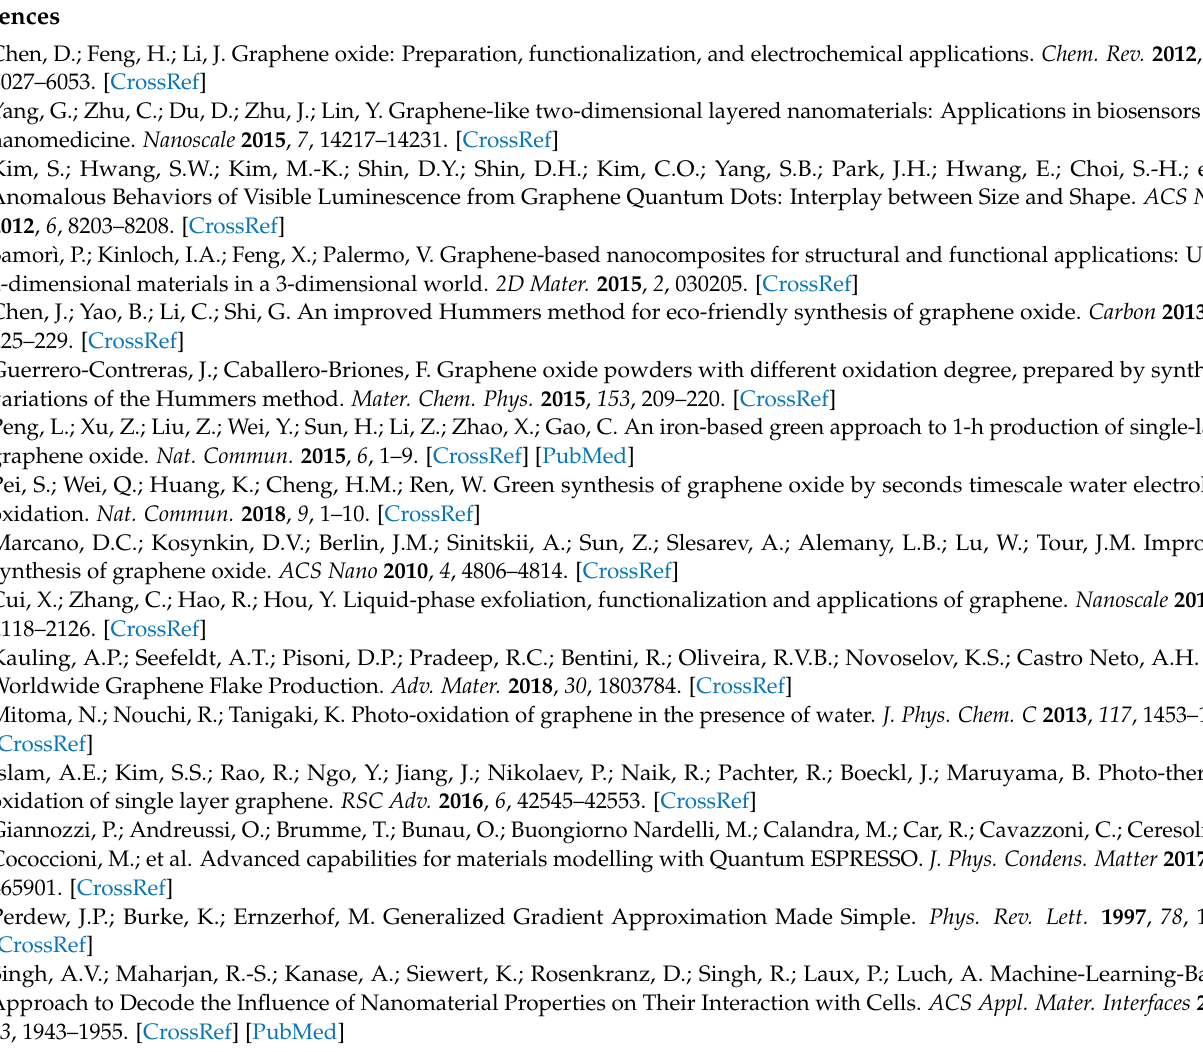
oxidation; Figure S2: Characterization of commercial GO obtained. High resolution C1s XPS spectra and their respective AFM images. Scales bar are 2 m. Figure S3: Characterization of commercial GO. (a) Raman, and (b) FTIR spectra; Table S1: Calculated local vibrational modes (LVMs) of oxygen and hydrogen functional groups in graphene. Only vibrational modes with frequencies above 600 cm − 1 and with localization (loc.) on O and H of 2% or larger are shown. Basal plane functional groups were modelled using a supercell model and edge functional groups were modelled using a graphene flake